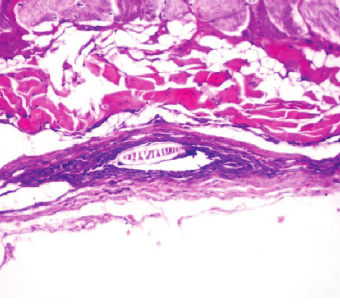
FIGURE 6 - Inflammatory reaction in group B30.